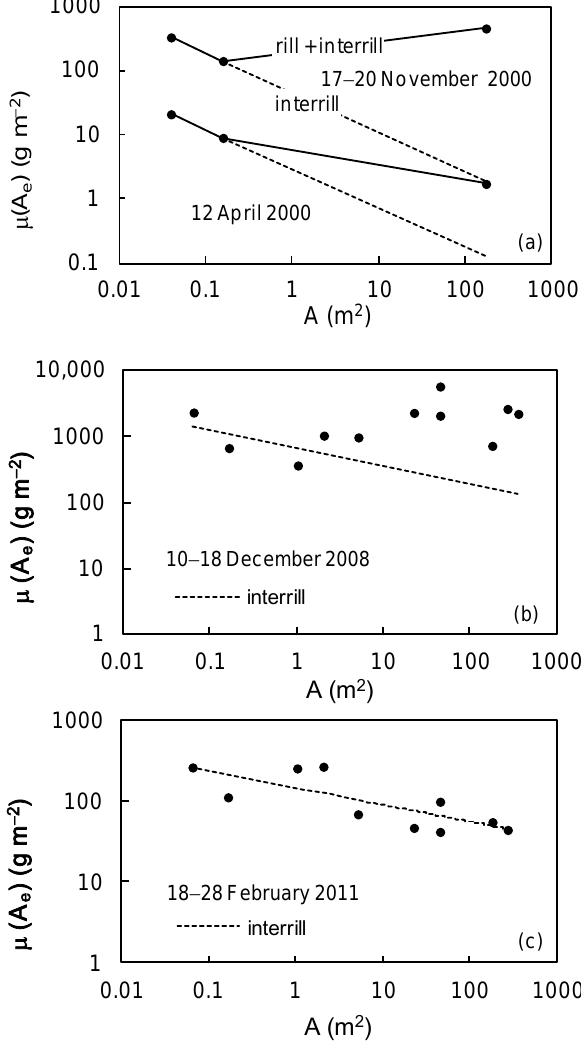
Figure 20. Relationship between mean soil loss, µ ( A e ), and plot area, A , for some selected events (modified from ( a ) [35], and modified from ( b , c ) [64]).